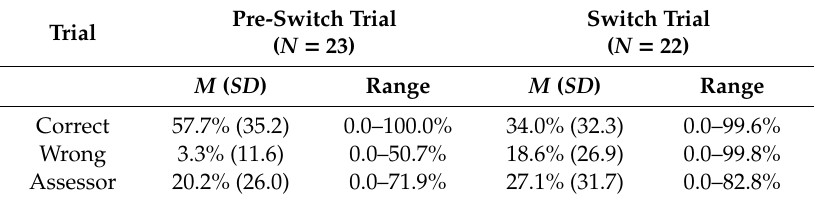
Table 1. Descriptive statistics of looking behavior data (percentage looking time) on the pre-switch and switch trial (all